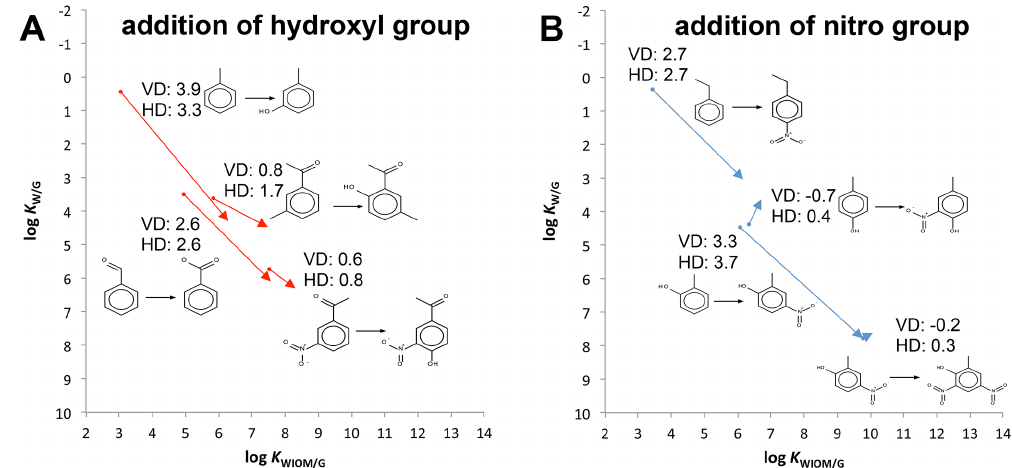
Figure 9. Displacement in the chemical partitioning space occurring upon the addition of a hydroxyl (a) or nitro (b) group to a mono-aromatic hydrocarbon, as predicted by SPARC for 15 ◦ C and using structure B for WIOM (VD: vertical displacement; HD: horizontal